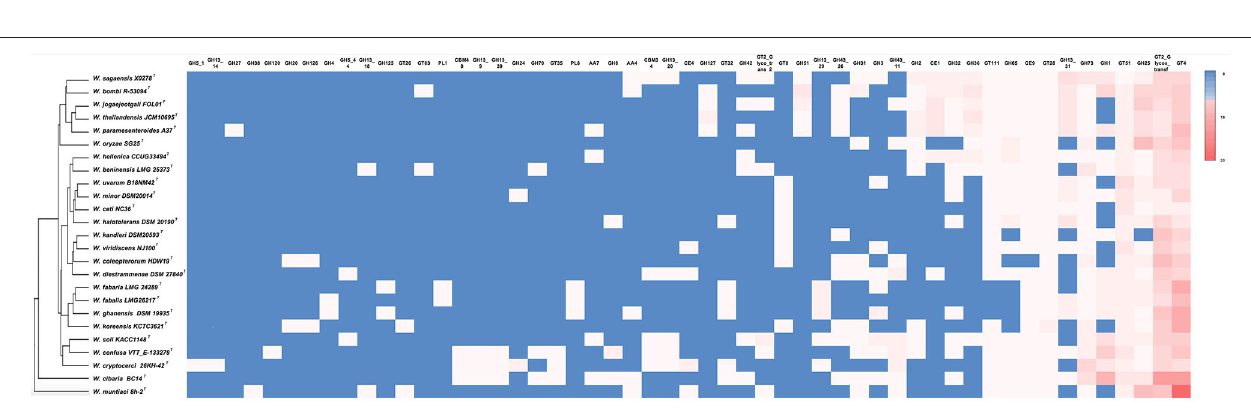
FIGURE 3 | Comparative analysis of CAZymes in Weissella species. The heatmap was manually constructed based on CAZymes count in each species and visualized with the average linkage as a clustering method and the Euclidean distance measurement method, providing the resulting dendrogram.